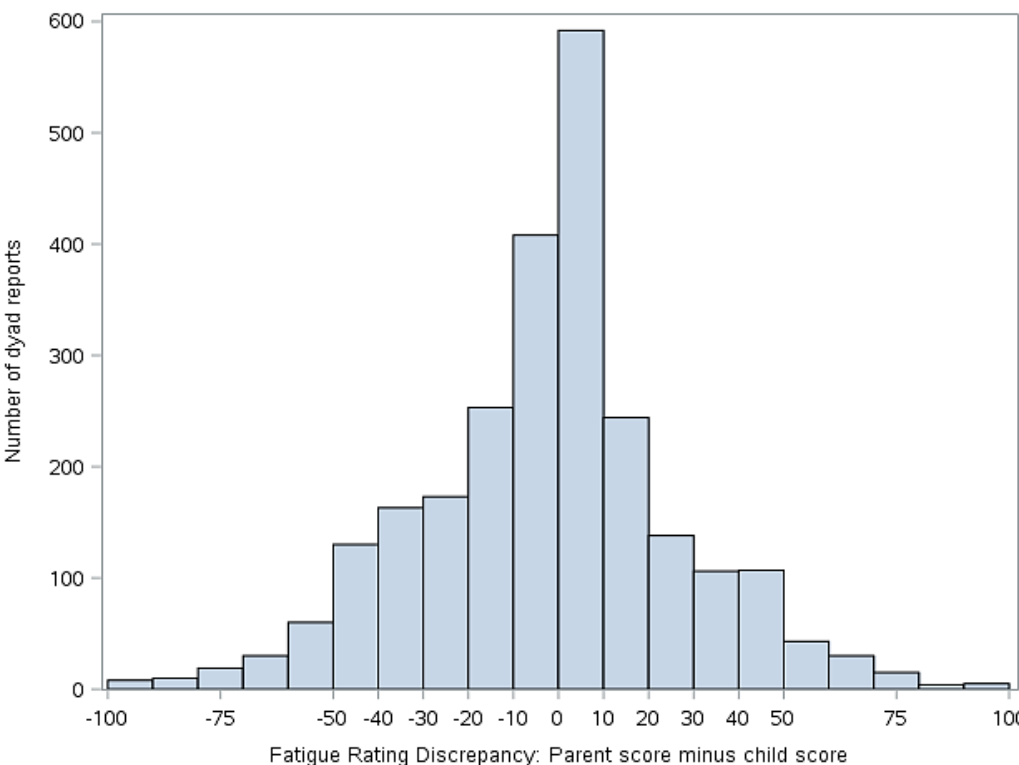
Figure 4. Discrepancy between child and parent rating of child fatigue (parent score minus child score). Positive values indicate that the parent scored the fatigue higher than the child. Negative numbers indicate that the child scored the fatigue higher than the parent.